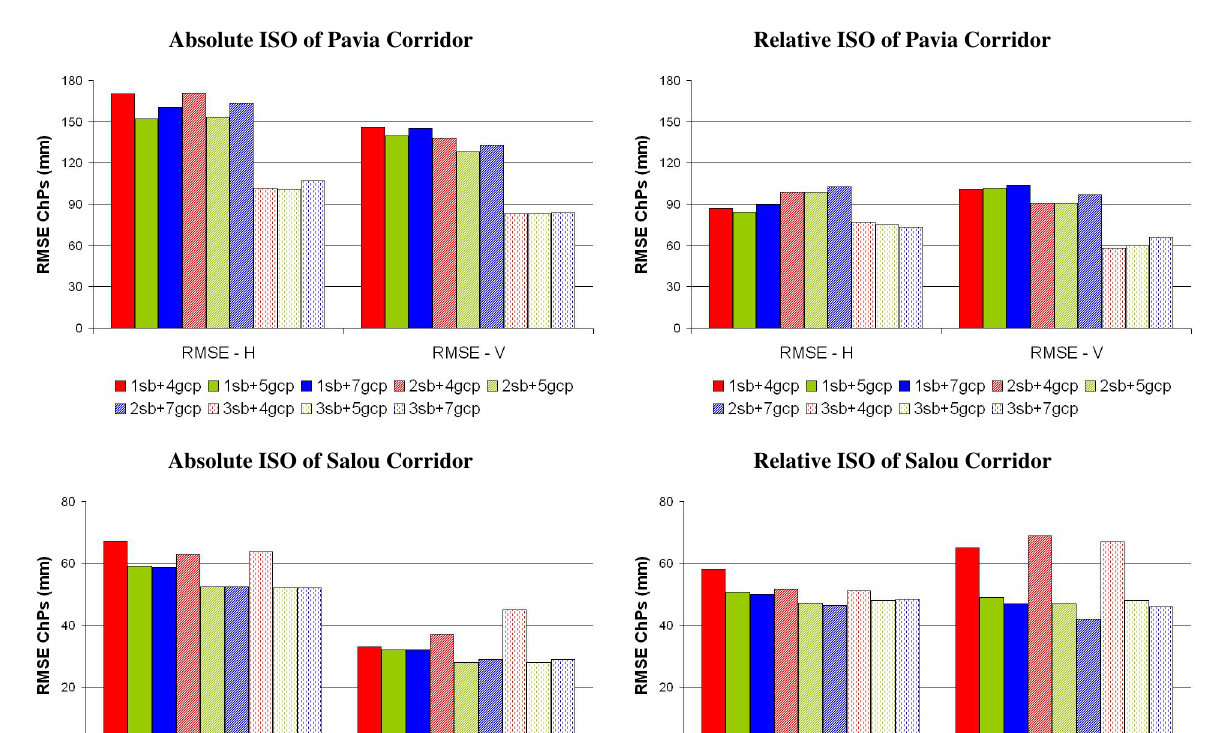
Figure 2: Salou corridor: sub-block and GCP configurations.